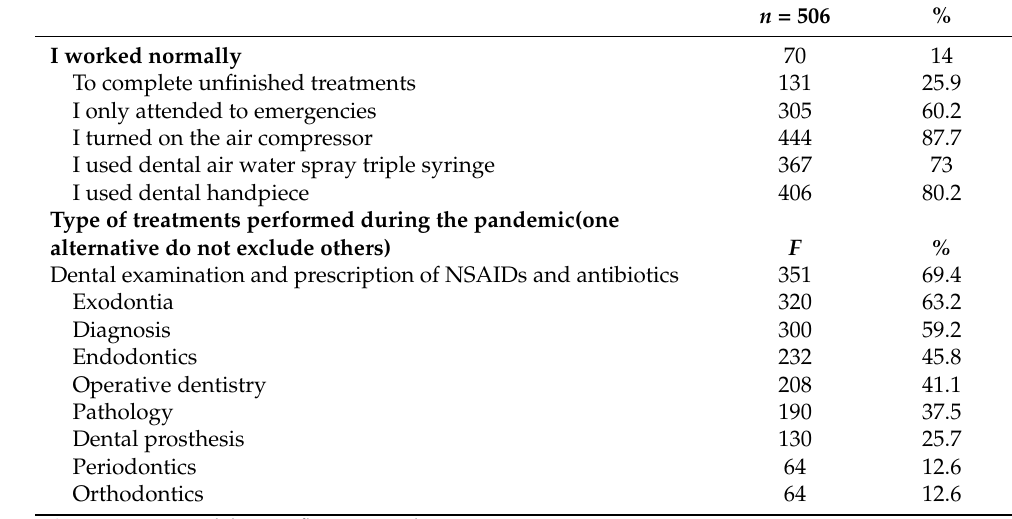
Table 3. Work patterns of dentists who worked during the active phase of the pandemic.